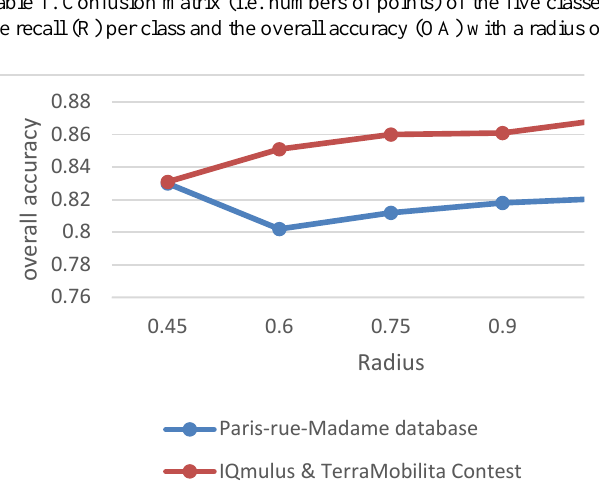
Table 1. Confusion matrix (i.e. numbers of points) of the five classes for Paris-rue-Madame database showing also the precision (P),